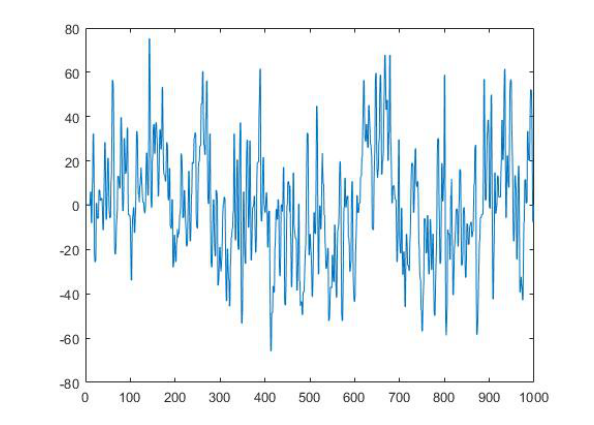
Figure 6. chb01-01 OWA Output